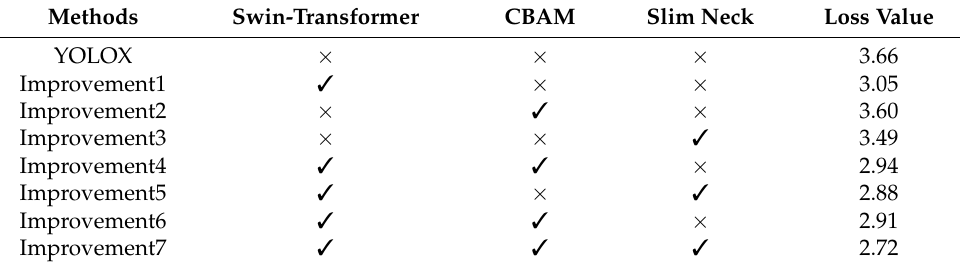
Table 2. Final training loss function values for different improvement methods.